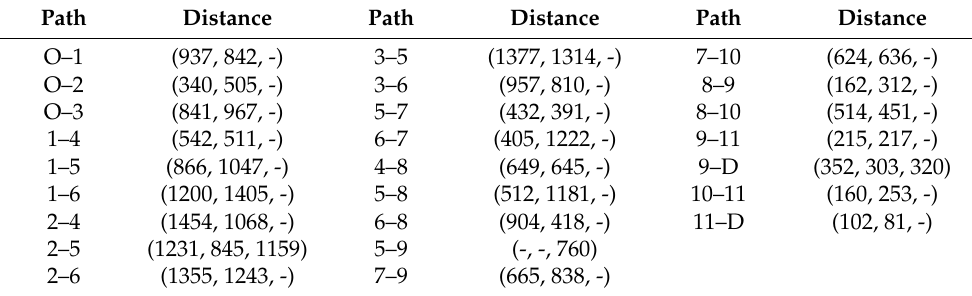
Table 2. Transportation distance of different modes between transportation nodes (unit: km).